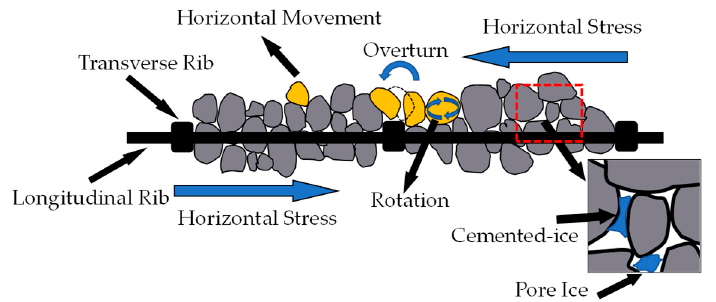
Figure 16. Interaction mechanism of reinforced soil composite under freezing state.